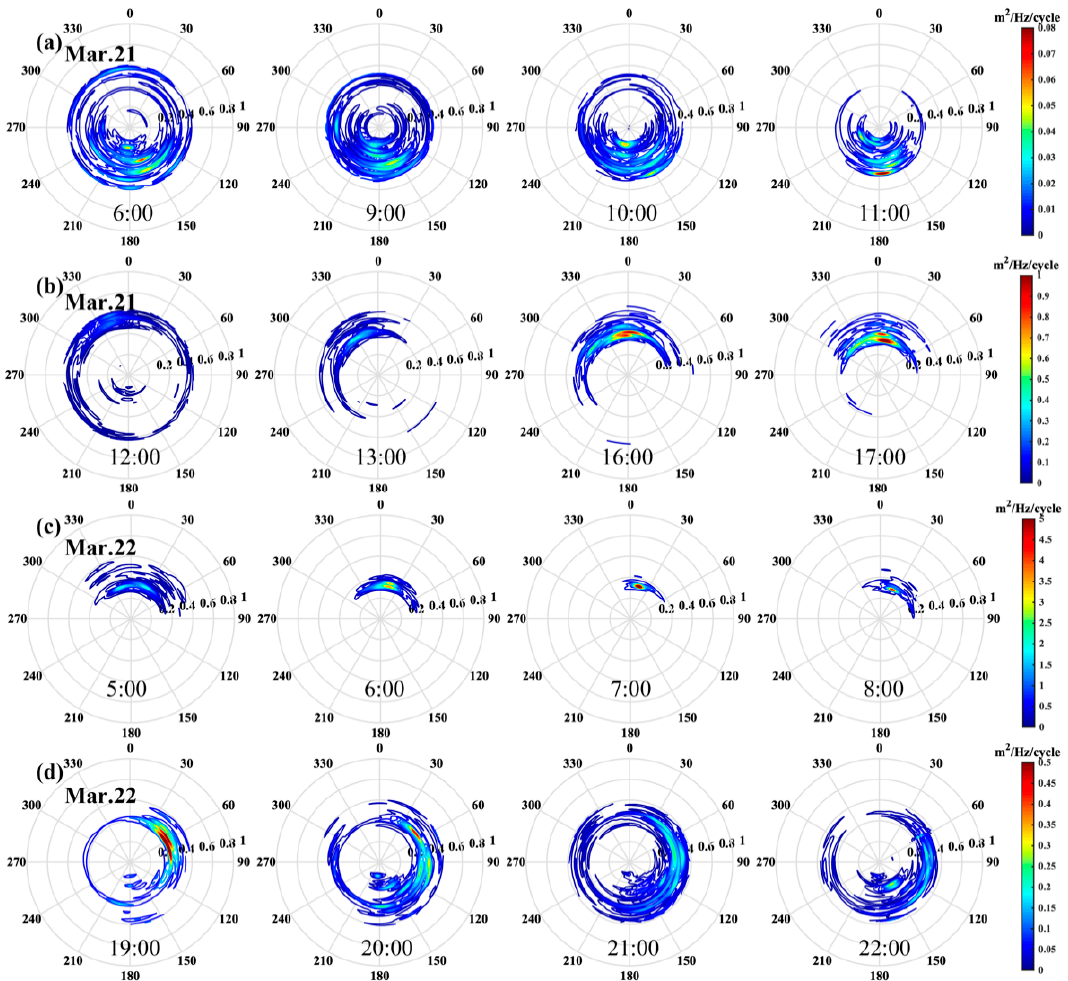
Figure 9. Hourly directional wave spectrum as observed by CSI 3 in the Case II. The 2-D directional spectra are shown in polar contours. ( a ) the prefrontal phase, ( b ) frontal passage phase ( c , d ) postfrontal phase from March 21 to 22.